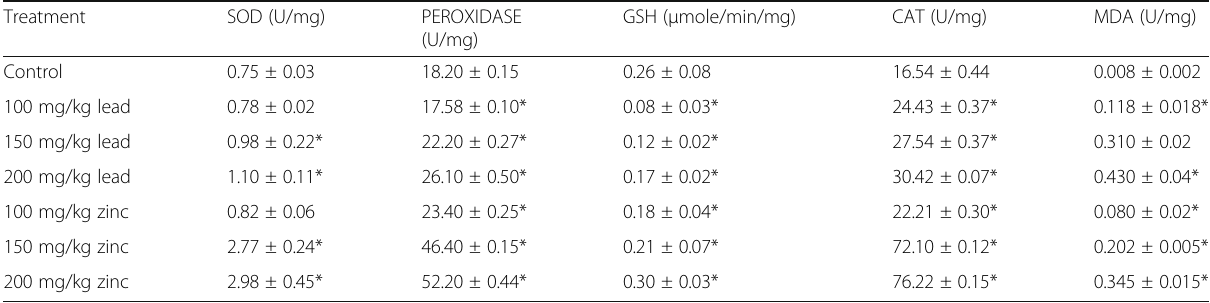
Table 1 Impact of different concentrations of Lead and Zinc nitrates on some Enzymes and Lipid Peroxidation in maize